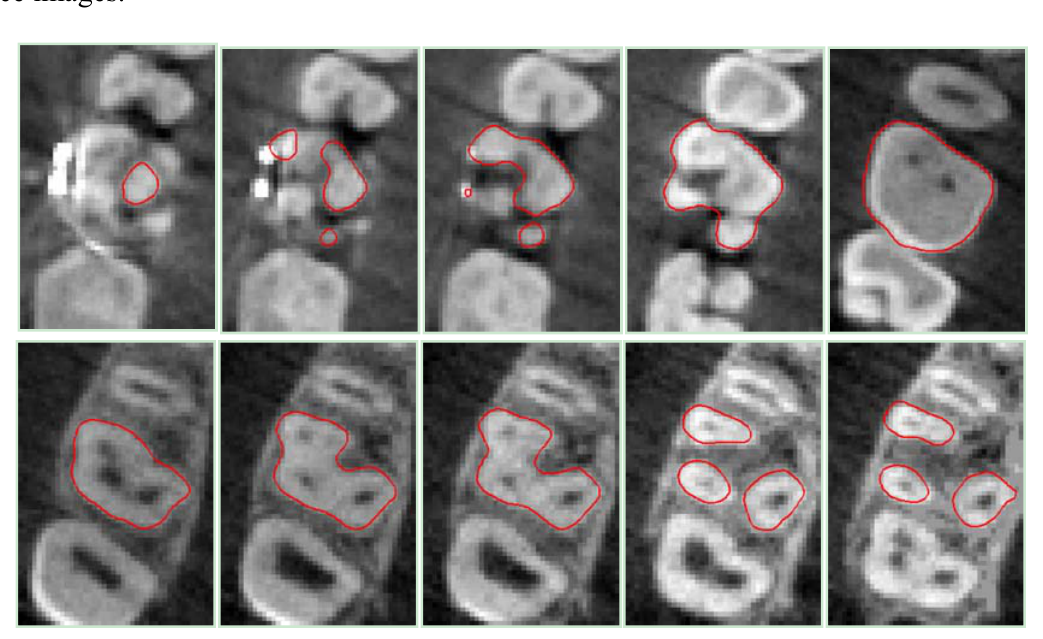
Figure 13. Results of the DRLSE method for tooth 16, obtained by processing some CBCT slice